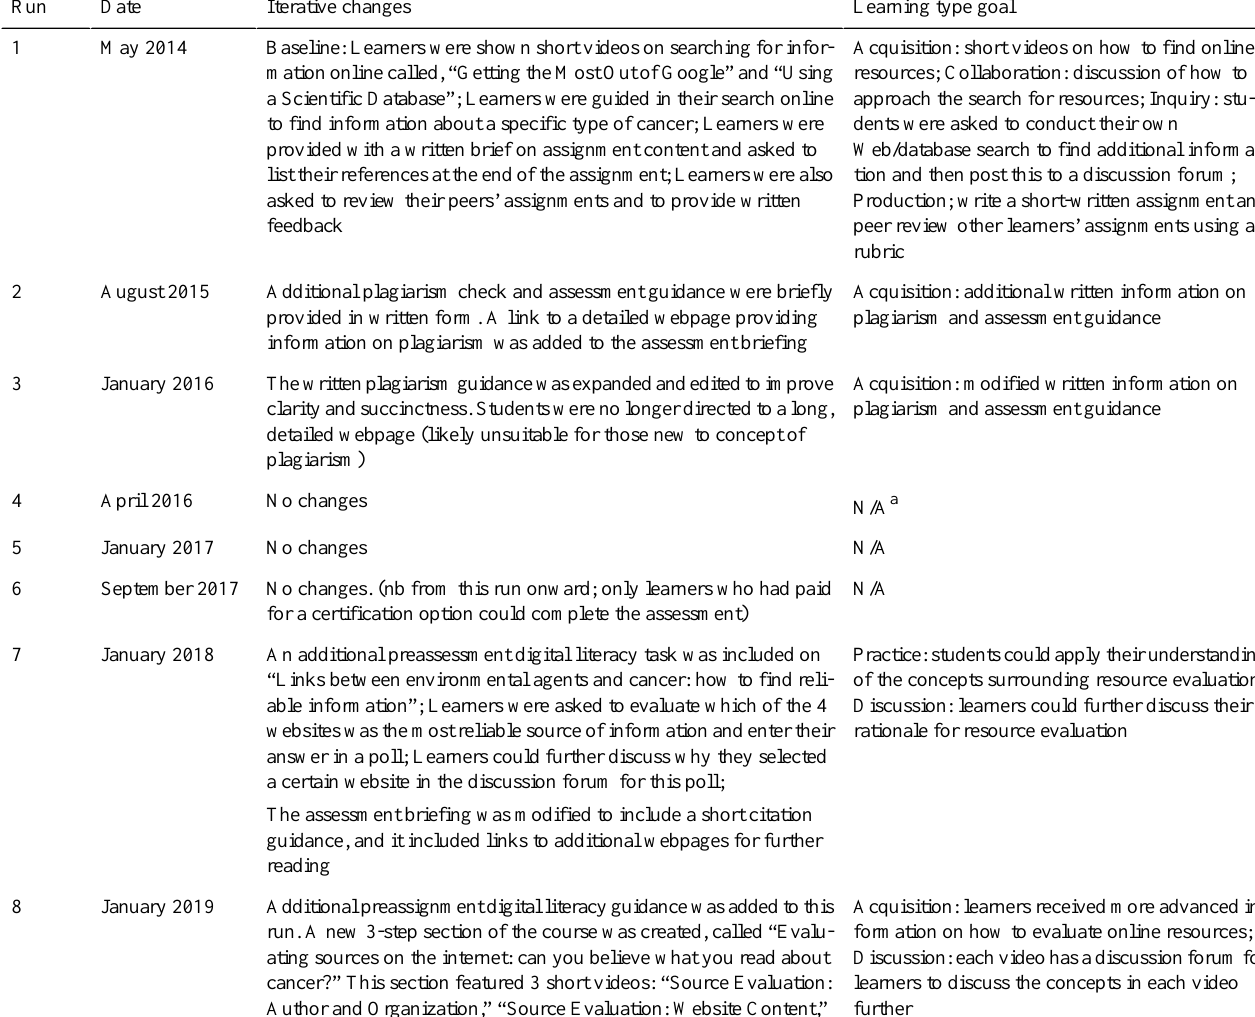
Learning type goalIterative